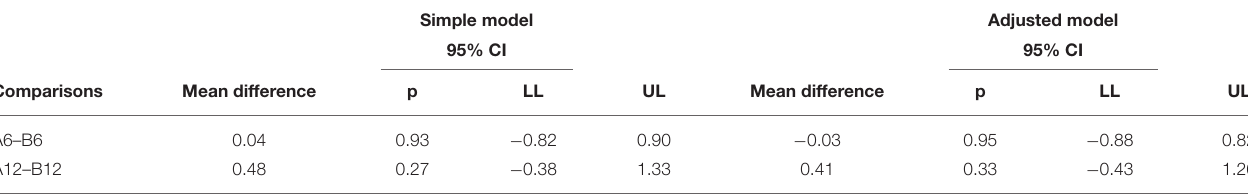
TABLE 2 | Serum IgE: comparison between Placebo (A) and Probiotics (B)